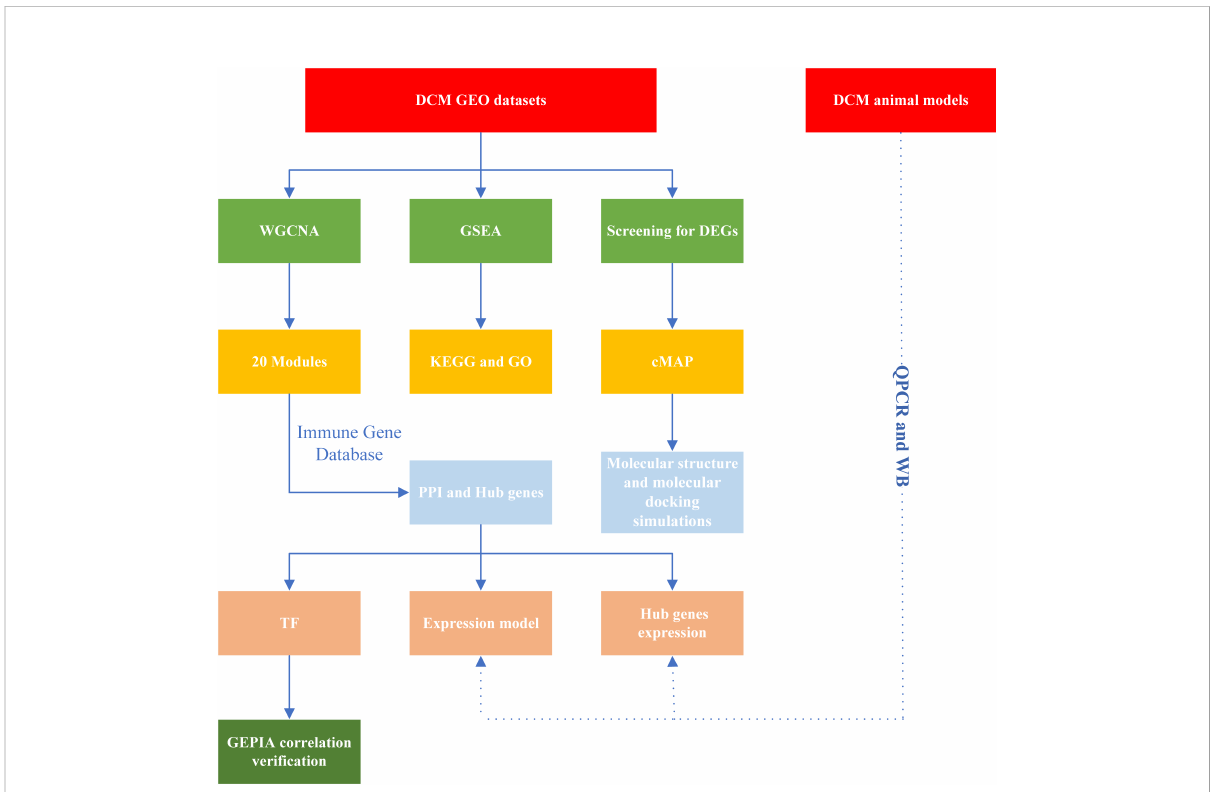
FIGURE 1 Study work fl ow. DCM, Diabetic cardiomyopathy; GEO, Gene Expression Omnibus; GO, Gene Ontology; PPI, protein-protein interaction; cMAP, Connectivity Map; KEGG, Kyoto Encyclopedia of Genes and Genomes; GSEA, Gene Set Enrichment Analysis; TF, transcription factors; DEGs, differentially expressed genes; WGCNA, Weight gene co-expression network analysis; GEPIA, Gene Expression Pro fi ling Interactive Analysis; QPCR, quantitative real-time PCR; WB, Western